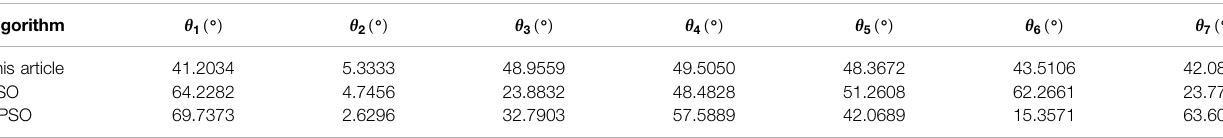
TABLE 10 | Joint angles according to different algorithms.